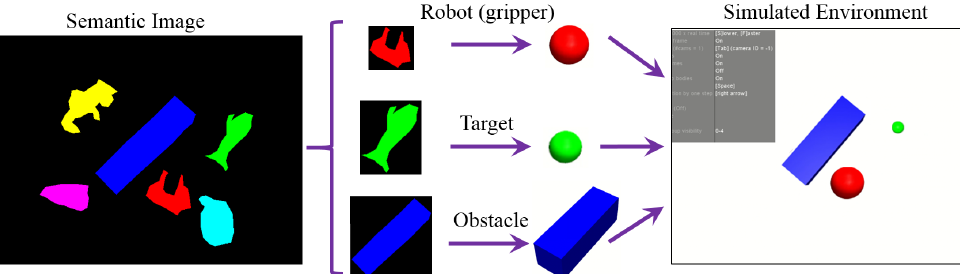
Figure 2. Illustration of generating a task-relevant simulated environment. The target object is simplified to its geometry center of the corresponding regions in the semantic image. The robot (or gripper) is equivalent to a solid ball, the center and diameter of which are calculated from its semantic pixel region contour. The obstacles are completely preserved, and other irrelevant objects that cannot be objects are ignored.